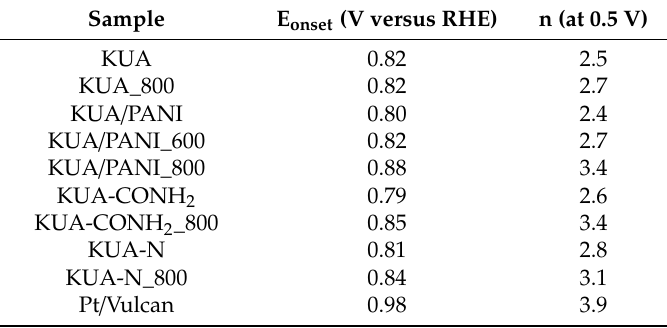
Figure 4. ( a ) Linear sweep voltammetry (LSV) curves for the catalysts in O 2 -saturated 0.1 M KOH at 1600 rpm. ( b ) LSV curves at different rotating rates for KUA/PANI_800. v = 5 mV/s. Table 4. Electrochemical parameters of the electrocatalysts calculated from the rotating ring-disk electrode (RRDE) experiments in O 2 -saturated 0.1M KOH at 5 mV/s and 1600 rpm.